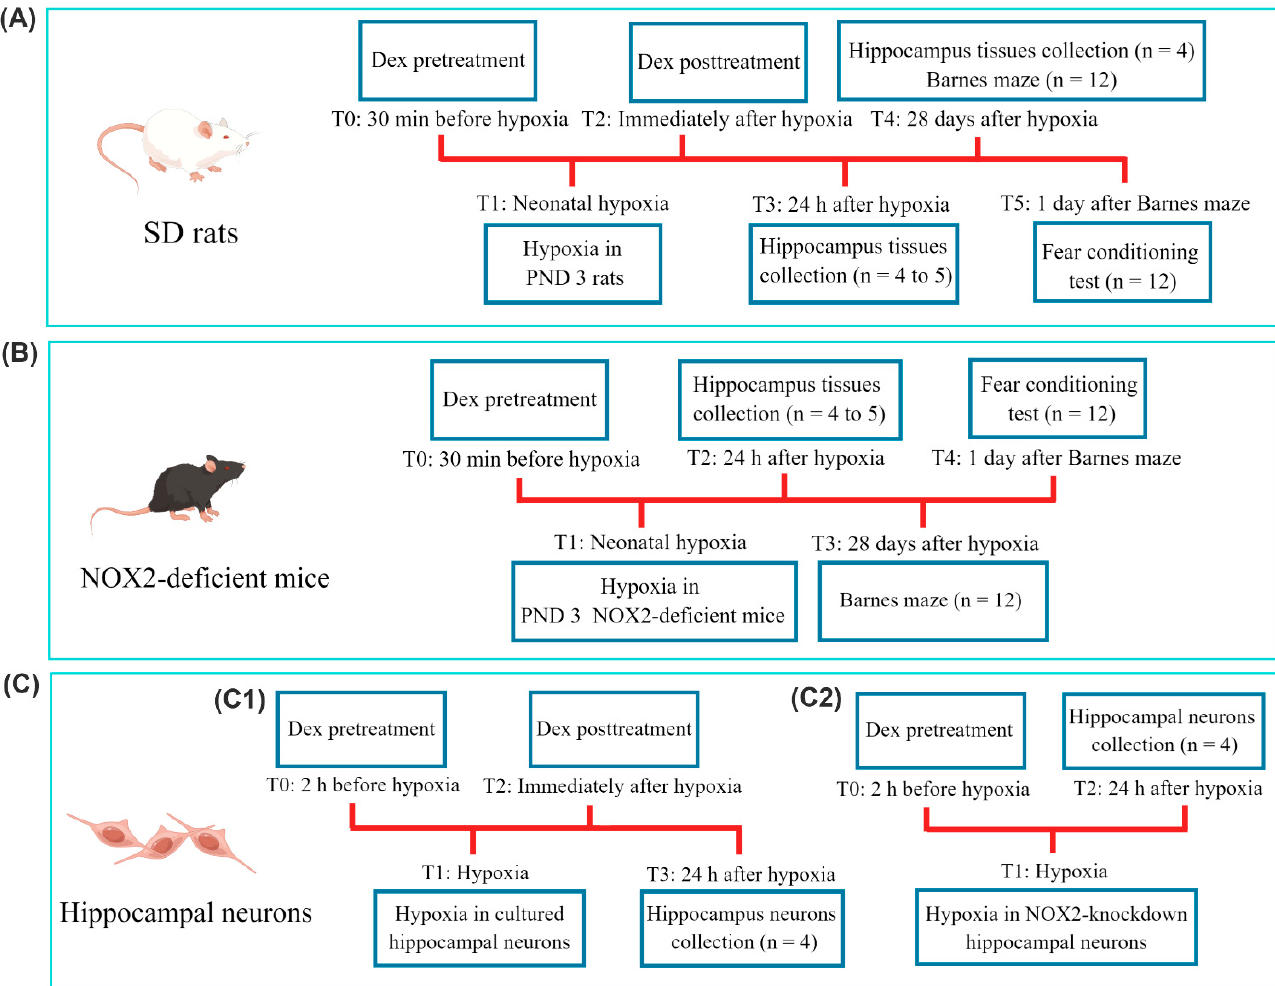
Figure 1. Schematic diagram summarizing the timeline of the experimental protocol. Procedures at different time points (T0 to T5) are described. ( A ) SD rats were subjected to hypoxia and Dex treatment on PND 3. ( B ) NOX2-deficient mice were subjected to hypoxia and Dex treatment on PND 3. ( C ) For the in vitro experiments, ( C1 ) cultured hippocampal neurons were subjected to hypoxia and Dex treatment. ( C2 ) Cultured hippocampal neurons were transfected with NOX2-siRNA or scrambled siRNA, and then subjected to hypoxia and Dex treatment. The n number in the diagram represents the number of animals per group or the number of experimental repeats. PND, postnatal day; SD rats, Sprague–Dawley rats; Dex, dexmedetomidine.